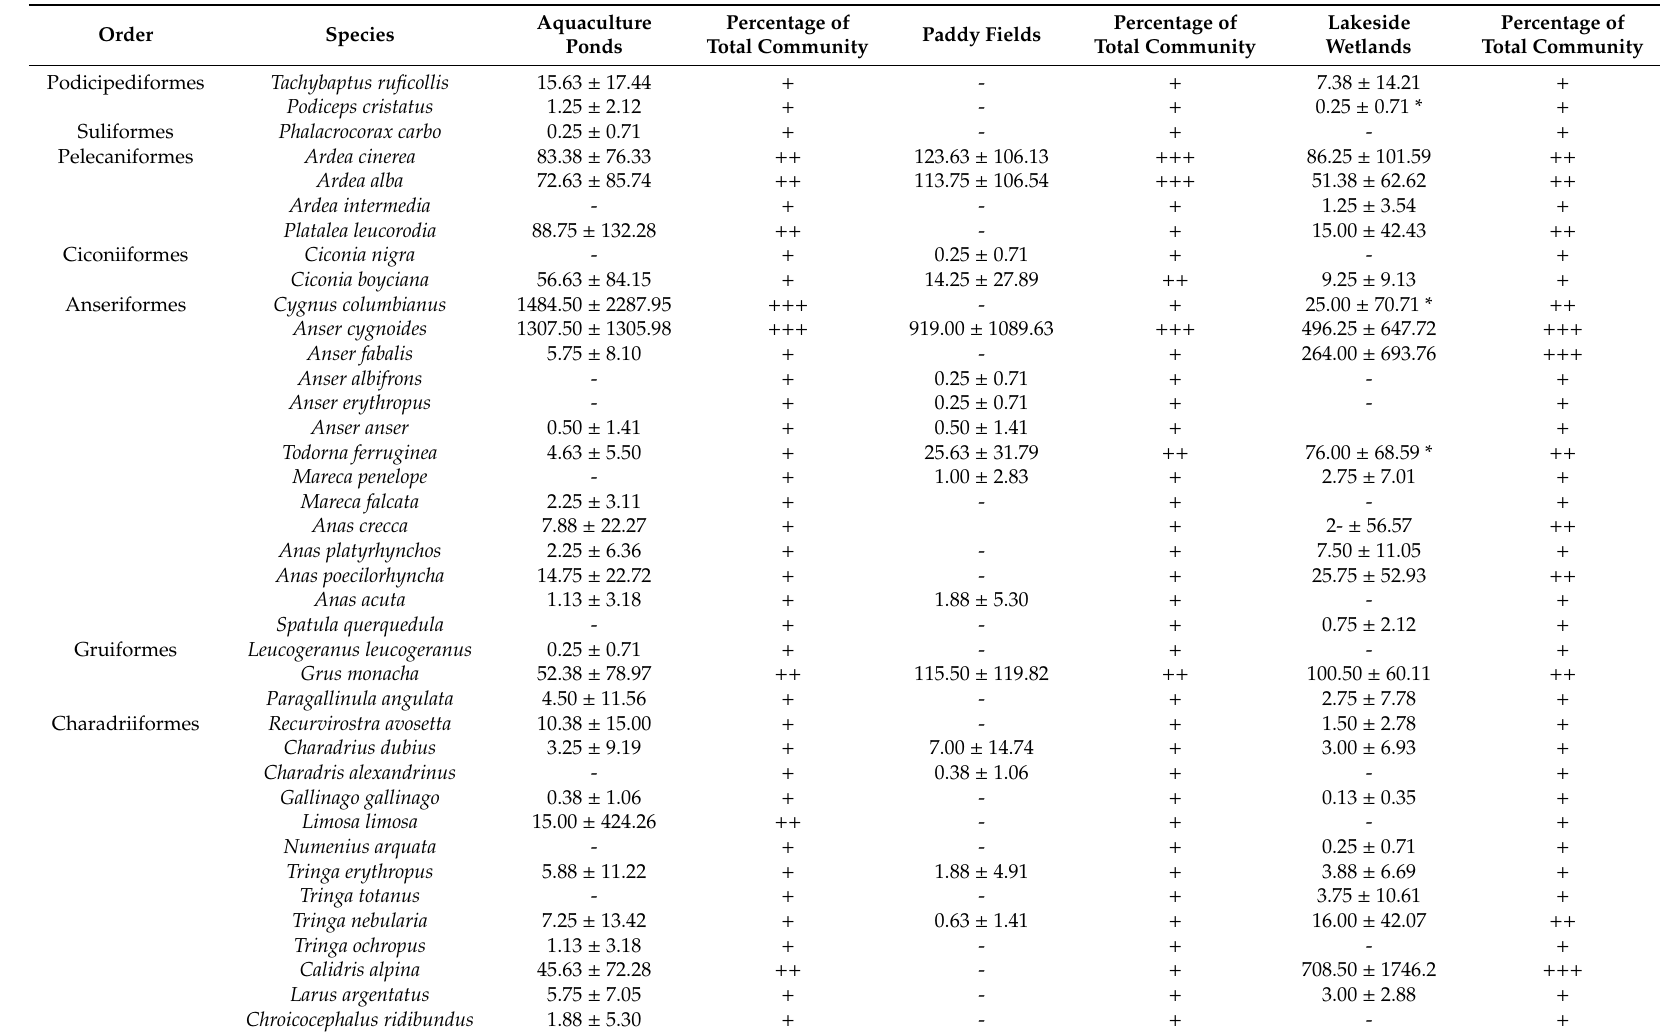
Table 3. Species richness of waterbirds in di ff erent